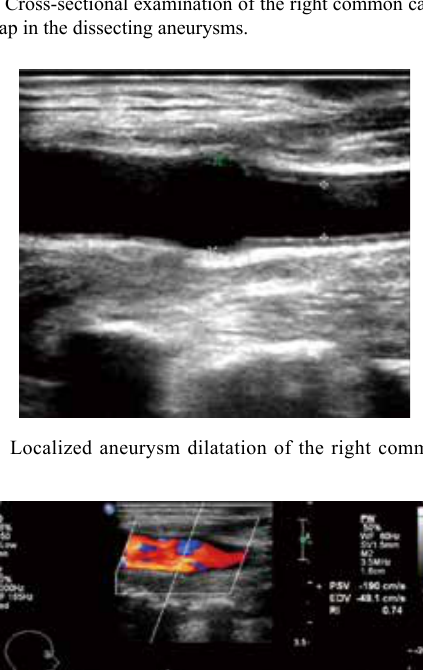
Figure 8 The left common carotid artery intramural hematoma dissection shrank after two months of conservative